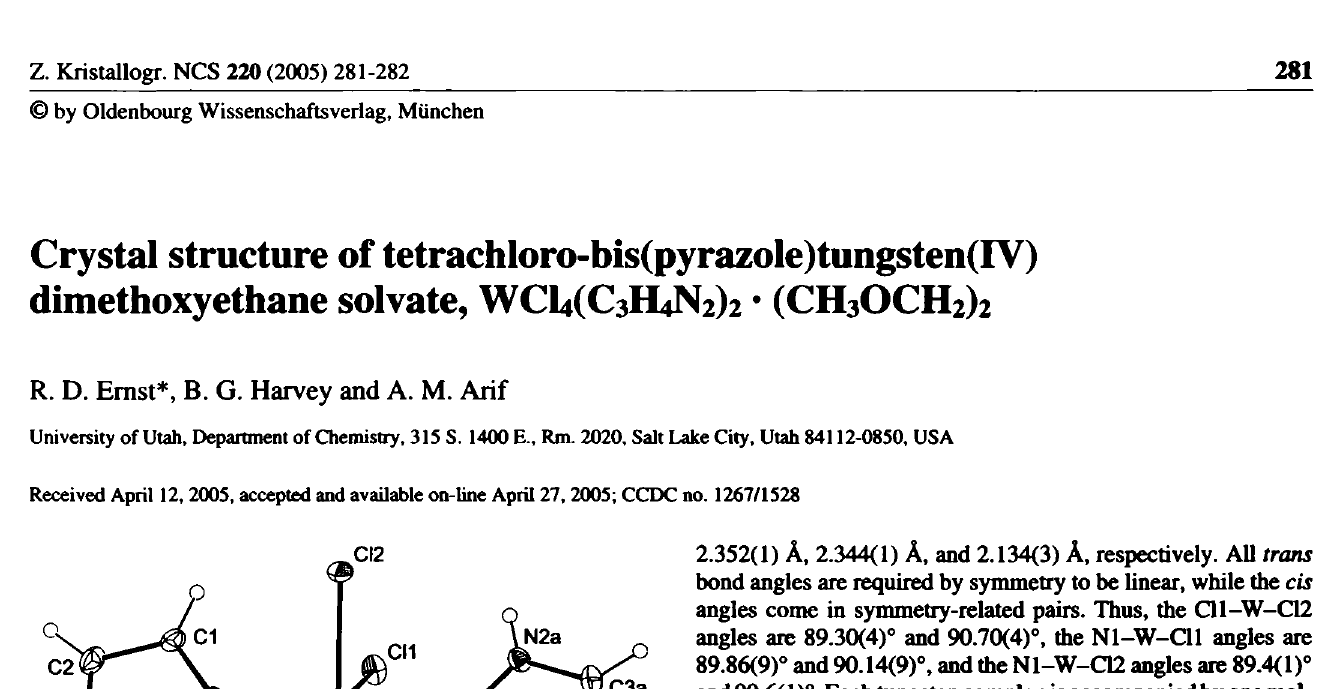
Table I. Data collection and handling.